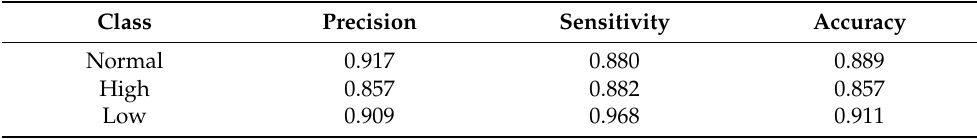
Figure 13. Averaged F-score curves of MFNN model as a function of the threshold for the decision of each class. Table 1. Statistical evaluation (precision, sensitivity, and accuracy) for each class of normal, high, and low chlorophyll- a concentration